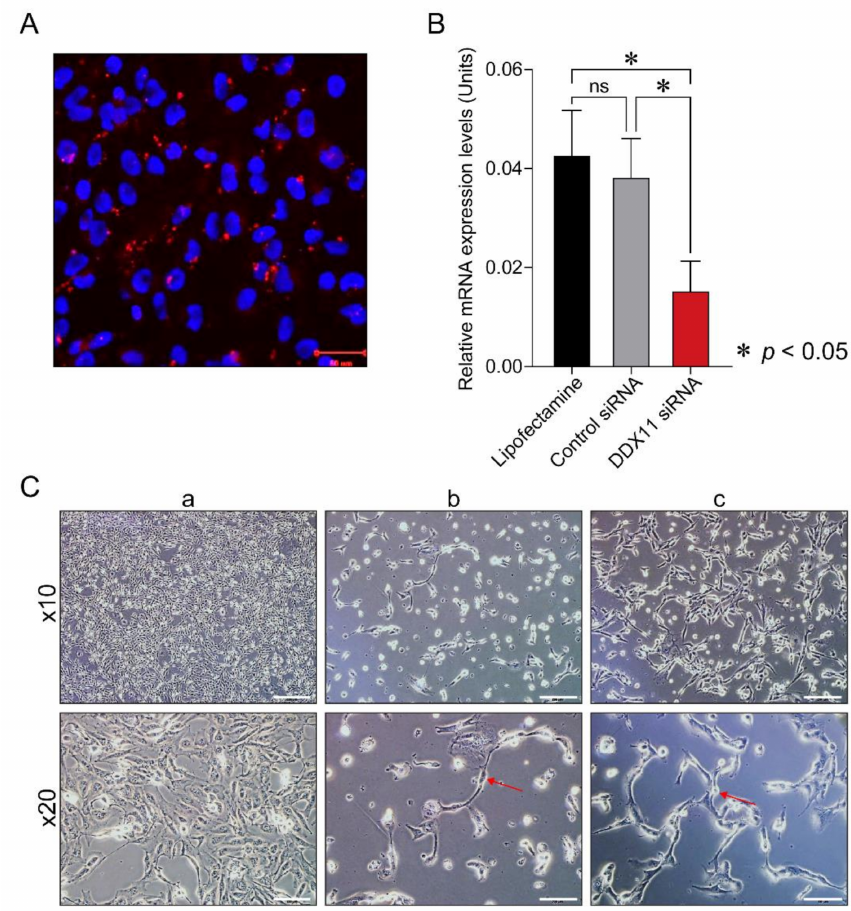
Figure 3. Analysis of DDX11 small interfering (si) RNA-transfected renal cell carcinoma cells. ( A ) Immunofluorescence to investigate DDX11 expression in 786-O cells 24 h following transfection with 5 nM of Cy5-conjugated DDX11 siRNA; DDX11 (pseudocolored red), nuclei (pseudocolored blue), Scale bar: 50 µ m. ( B ) Quantitative PCR investigating the expression of DDX11 in 786-O cells that received only Lipofectamine (black-colored filled bar) or were transfected with 25 nM of control siRNAs (gray-colored filled bar) or DDX11 siRNA (red-colored filled bar) for 48 h (* denotes p value less than 0.05). ( C ) Phase-contrast images, captured at 20 × magnification, depicting the morphology of 786-O cells following transfection with 50 nM of control siRNAs for 96 h ( a ) or with 25 nM ( b ) or 50 nM ( c ) of DDX11 siRNA for 24 h. The red-colored arrow in the phase-contrast images, shown in panels b and c , points to the chain-like morphology of 786-O cells that did not separate, Scale bar: 200 µ m (upper row), 100 µ m (lower